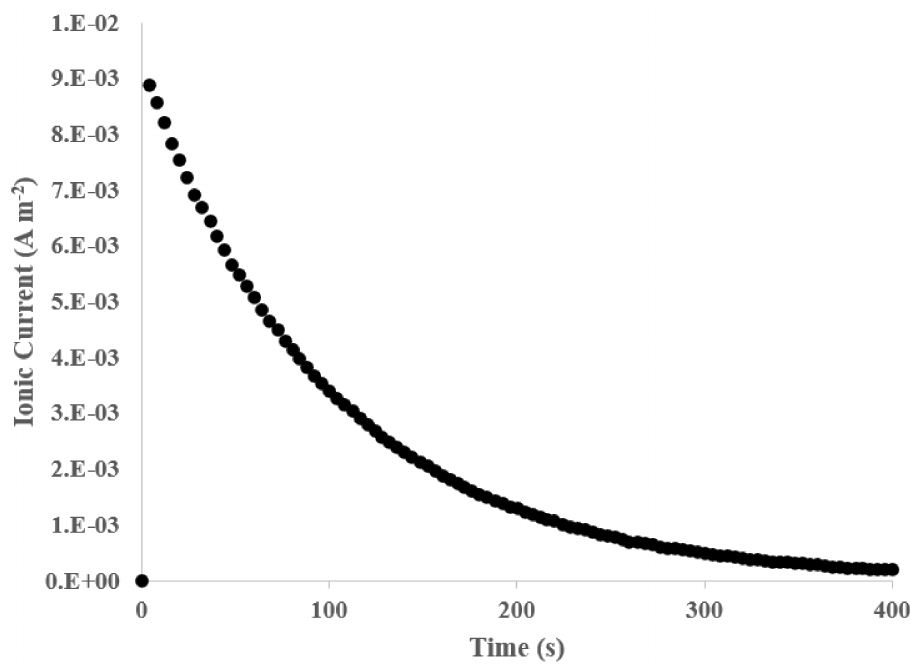
Figure 9. Net ionic current variation with